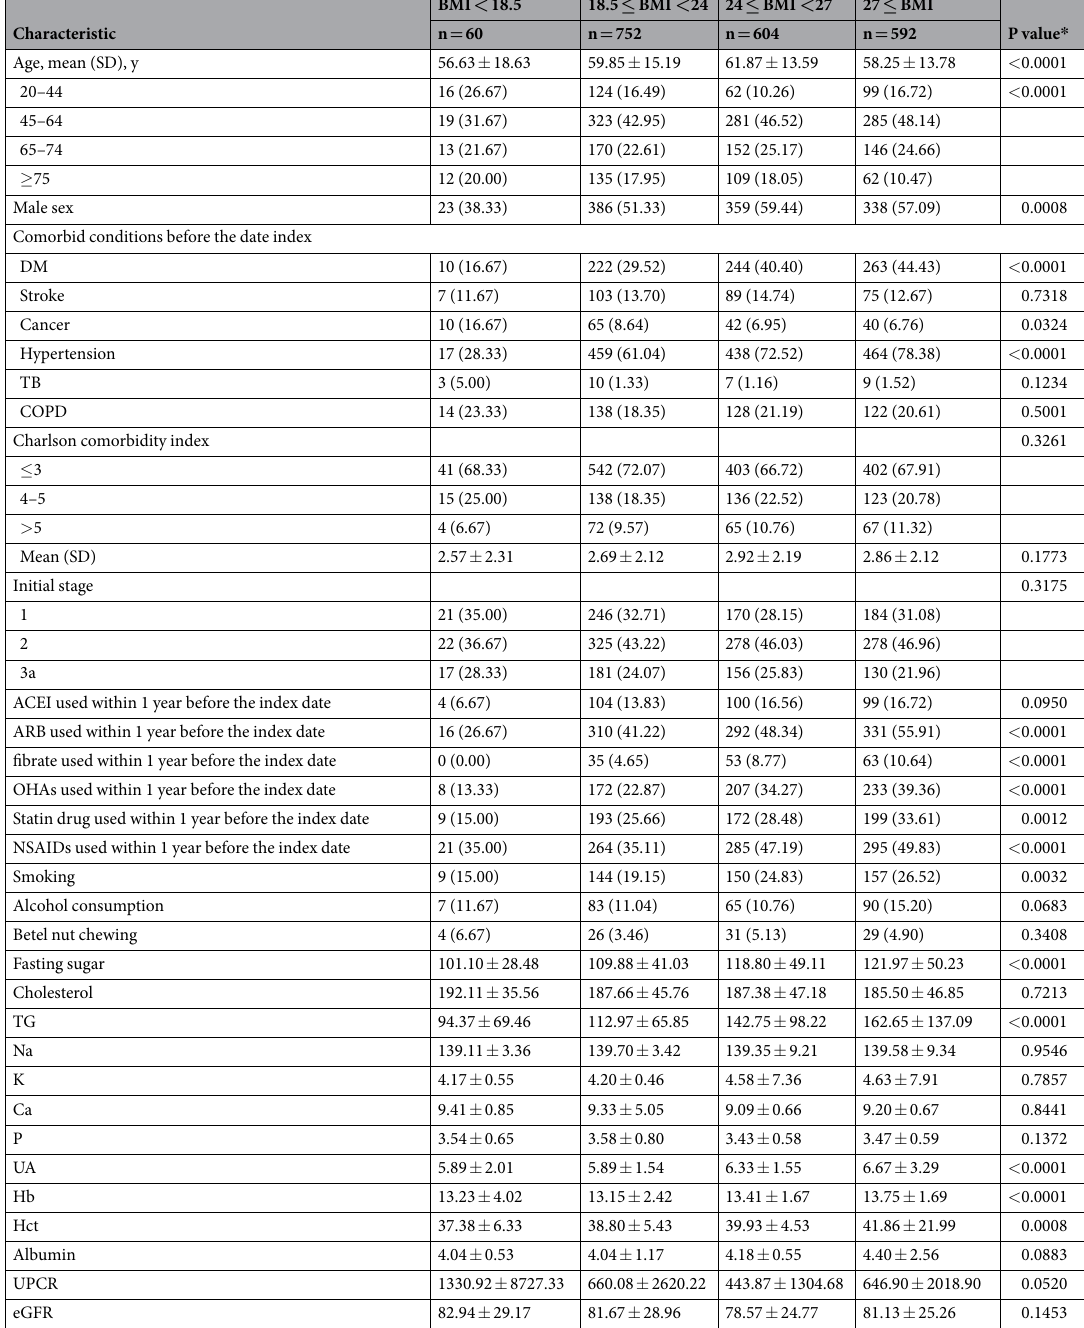
Table 2. Baseline characteristics of CKD stages 1–3a according to different BMI. * Categorical variables: